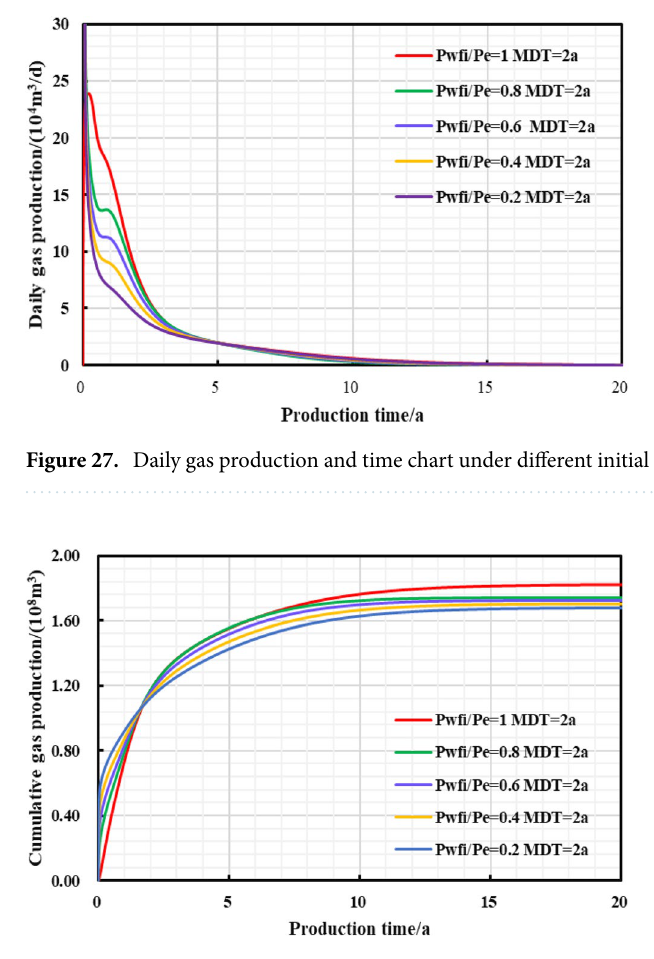
Figure 28. The cumulative gas production and time chart under different initial controlled pressures.